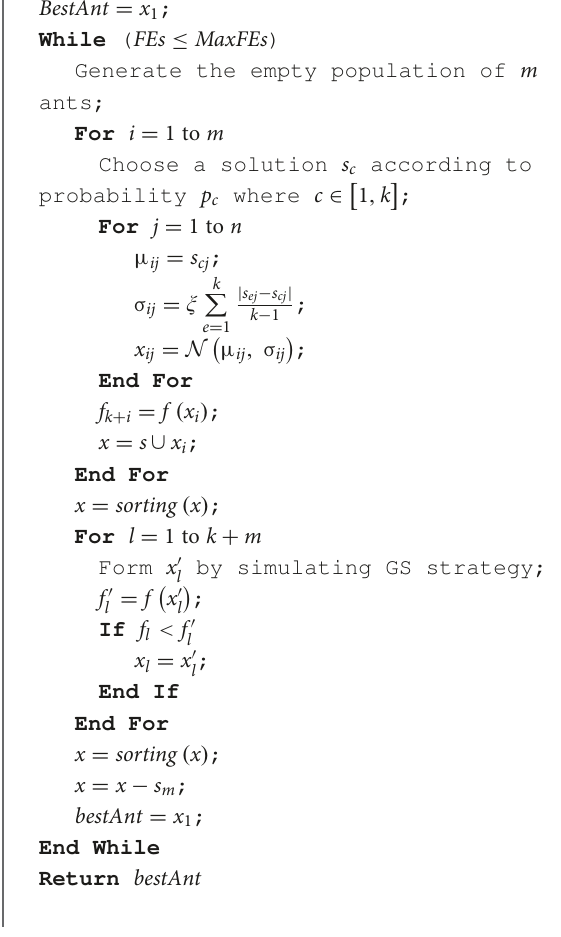
Algorithm 1. Pseudo-code of